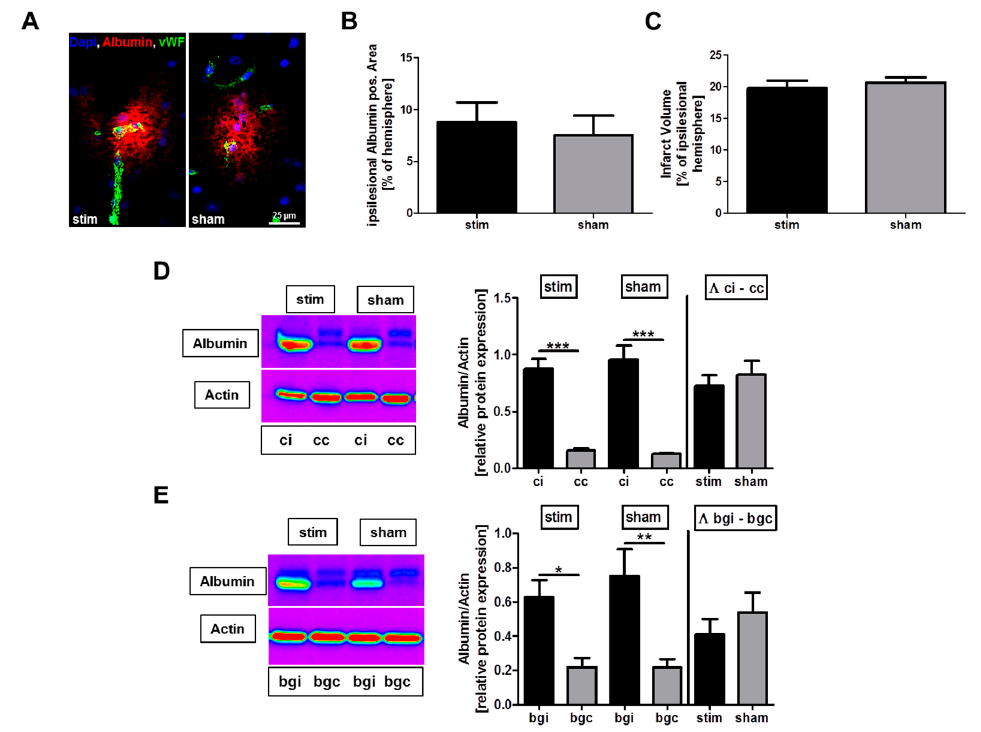
Figure 1. Stimulation of the mesencephalic locomotor region (MLR) in the acute phase after photothrombotic stroke does not alter albumin extravasation and lesion size. ( A ) Representative immunocytologic staining of albumin within the cortical ischemic penumbra of a high-frequency stimulated (stim) and an unstimulated (sham) rat. ( B ) Quantification revealed comparable